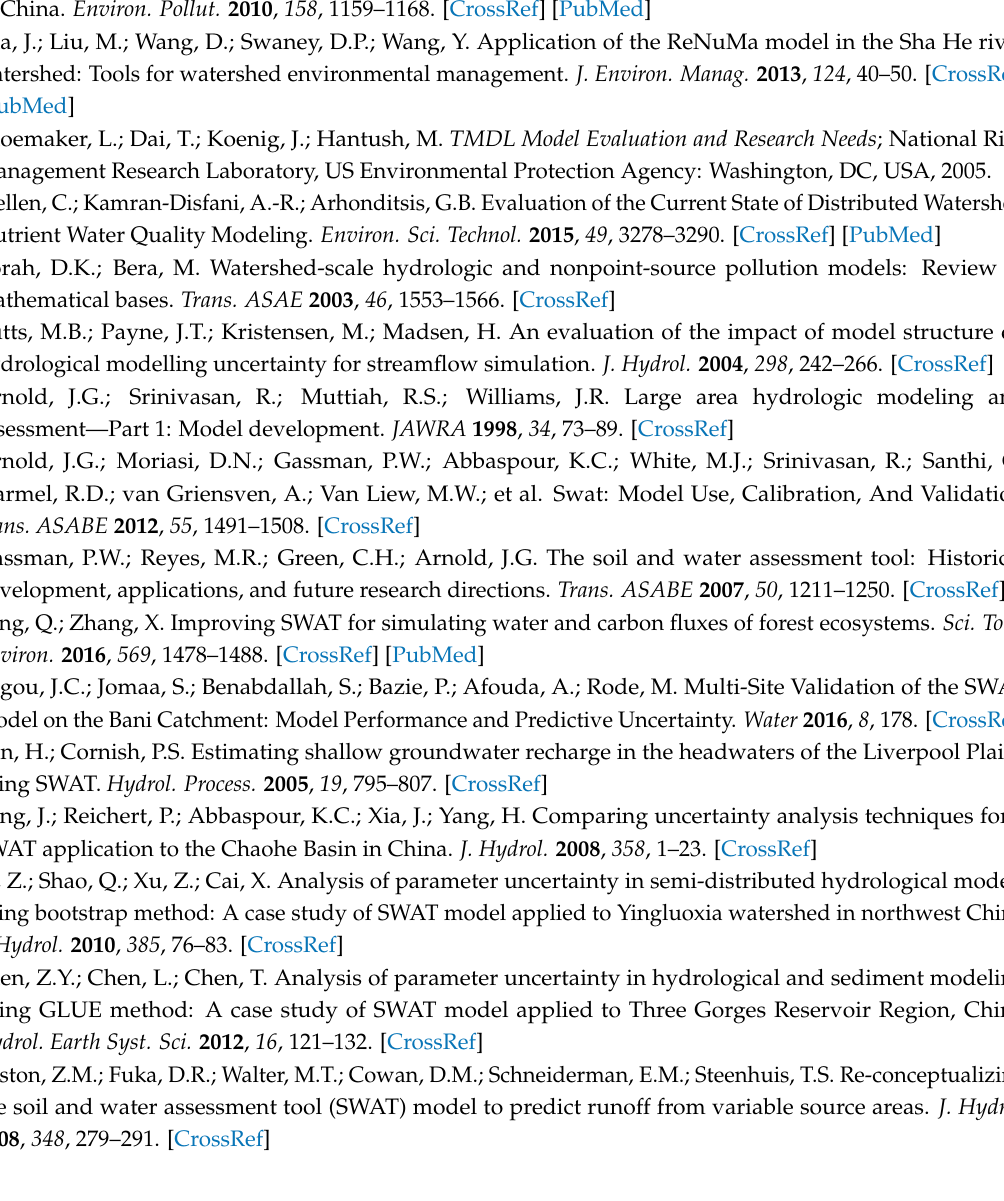
Figure S1: The interface of the SWAT model, Figure S2: The interface of the SWAT-CUP, Figure S3: The interface of GWLF modeling platform-ReNuMa. The Software is freely available for download from: http://swat.tamu.edu/ (assessed on 28 July 2017) and http://www.eeb.cornell.edu/biogeo/nanc/usda/renuma.htm (assessed on 28 July 2017),